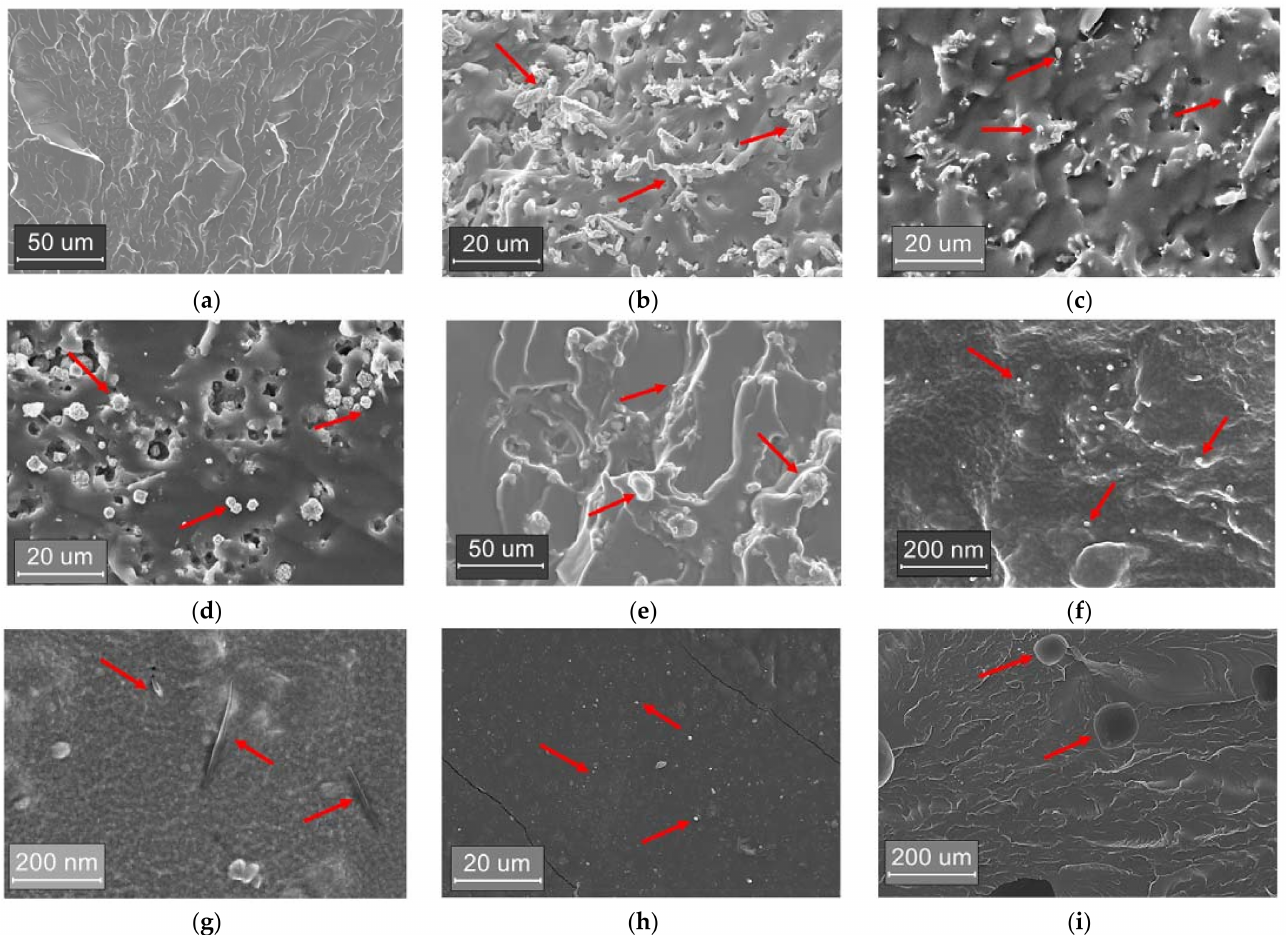
Figure 4. SEM imagines for composite, the red arrows highlight the filler and in the picture I the voids; ( a ) pristine Sylgard, 100 × ; ( b ) Cu15D, 400 × ; ( c ) Cu15S, 4000 × ; ( d ) Ni15, 400 × ; ( e ) NiL15, 100 × ; ( f ) BN6.6, 10,000 × ; ( g ) CNT0.6, 10,000 × ; ( h ) CB4.4, 400 × ; ( i ) CB4.4 100 ×